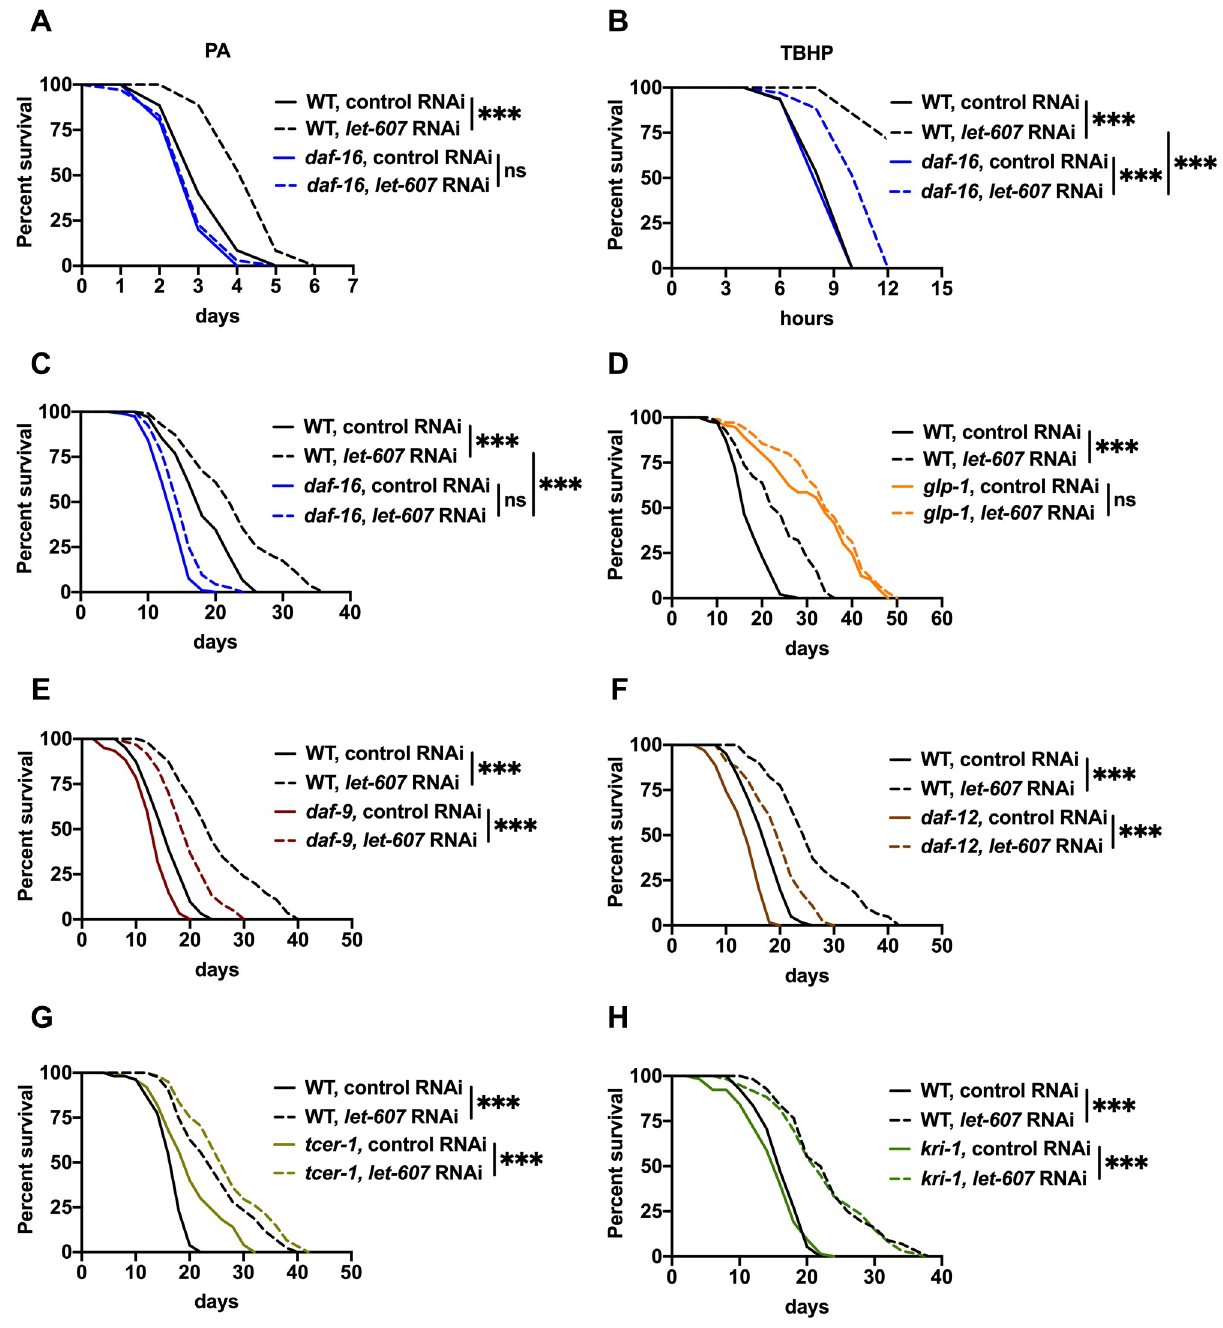
Fig 3. Suppression of LET-607 increases stress resistance and extends lifespan via DAF-16. (A-C) Effects of let-607 RNAi on pathogen resistance (A), TBHP resistance (B), and lifespan (C) in wild-type (WT) and daf-16 mutant worms. (D) Effects of let-607 RNAi on the lifespan of glp-1 mutants. (E-H) Effects of let-607 RNAi on the lifespan of daf-9 (E), daf-12 (F), tcer-1 (G) and kri-1 (H) mutants. ��� p < 0.001 versus empty vector controls.